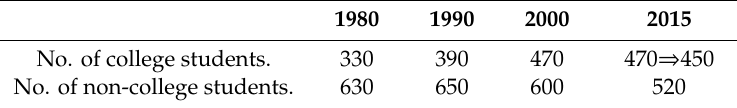
Table 2. Trend of YABs at Youngnak Presbyterian